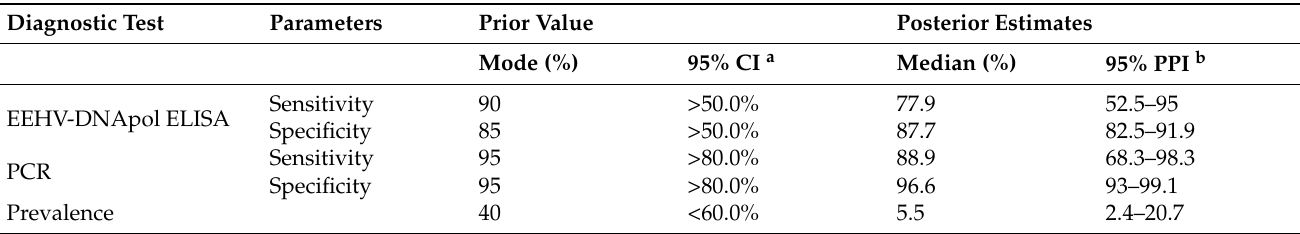
Table 2. Prior values and posterior estimation for sensitivity and specificity of the EEHV-DNApol ELISA test, the PCR test, and the degree of prevalence of the disease